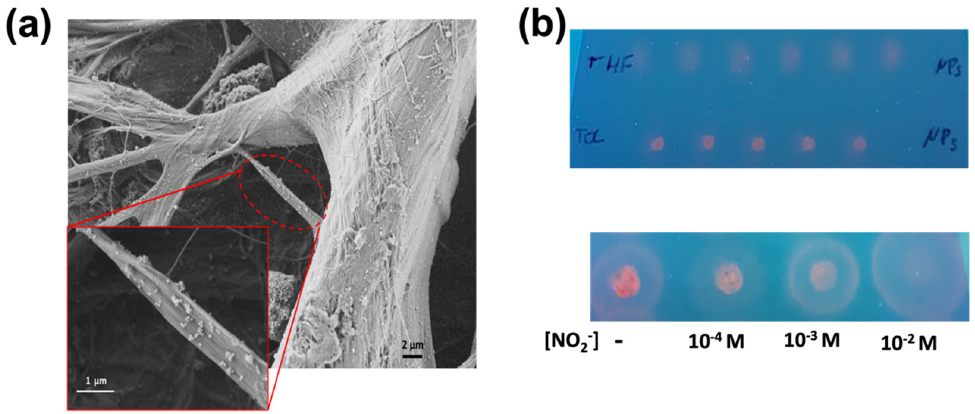
Figure 8. ( a ) SEM image of SiO 2 NPs@ PFCorr distribution on cellulose fibers; ( b ) the pictures of